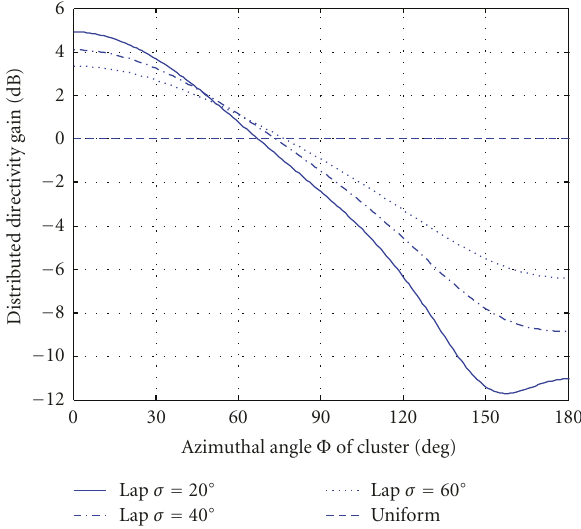
Figure 7: DDG for the directional beam pattern by the ESPAR an- tennas in di ff erent spatially distributed radio